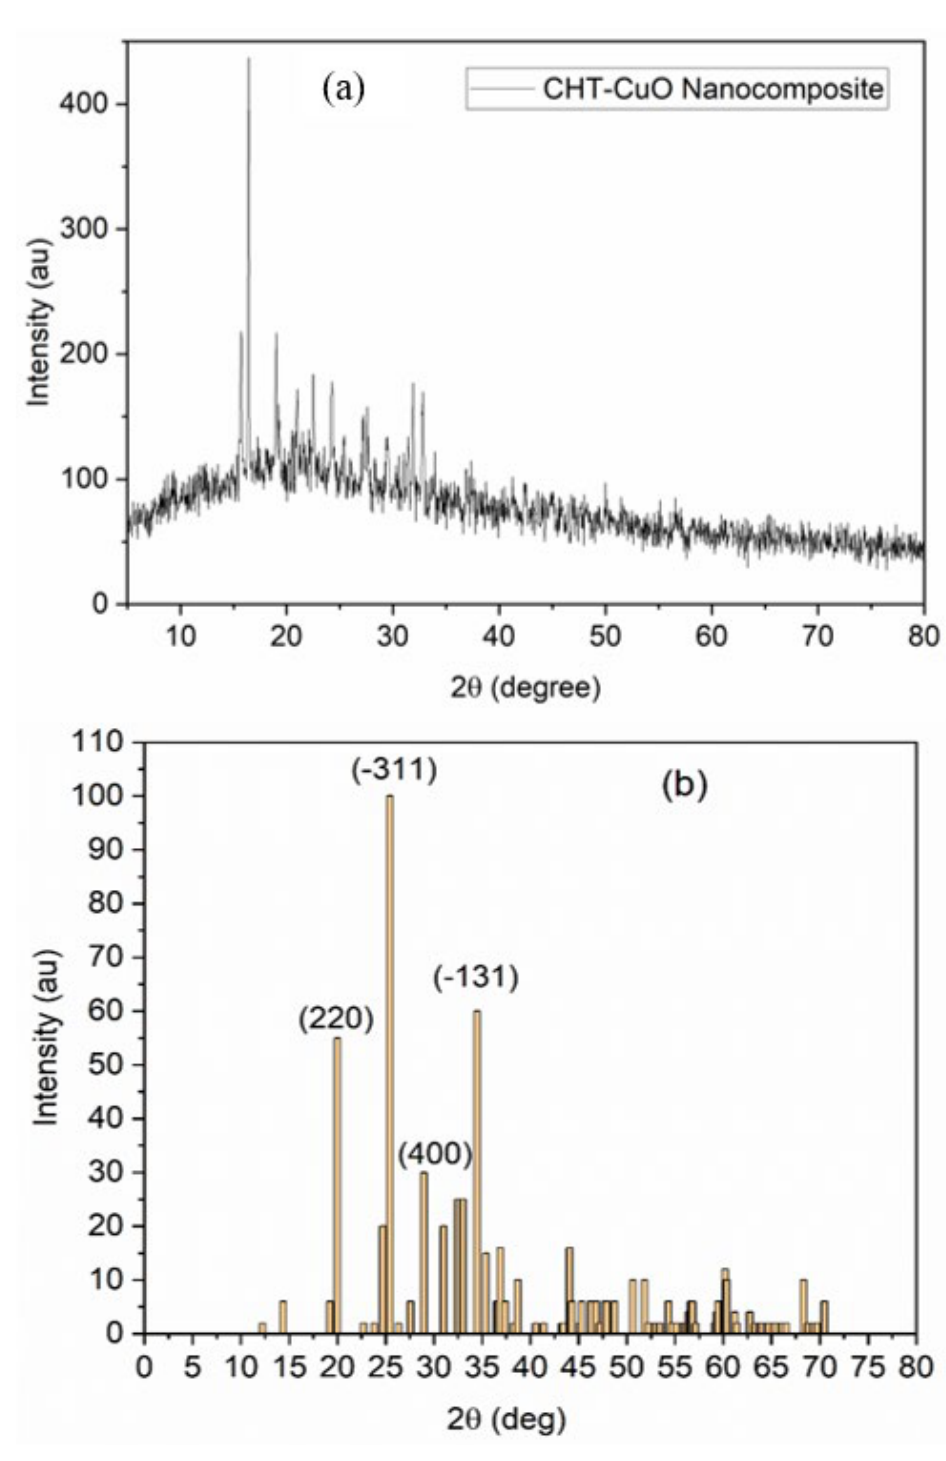
Figure 5. ( a ) XRD pattern and ( b ) XRD peak plots for CHT − CuO nanocomposites.